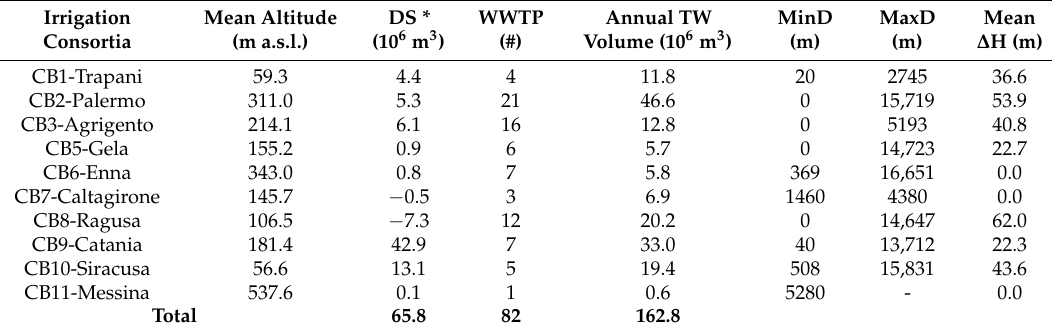
Table 2. Potential availability of TW at the consortium